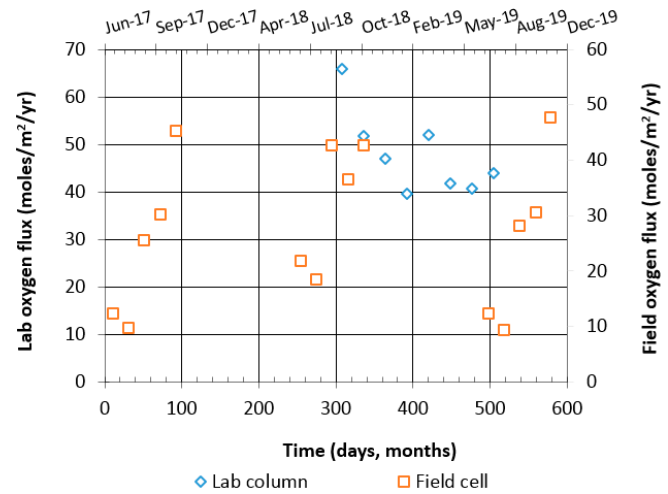
Figure 12. Oxygen fluxes calculated using the sulfate release method for CCBE column and CCBE field cell.